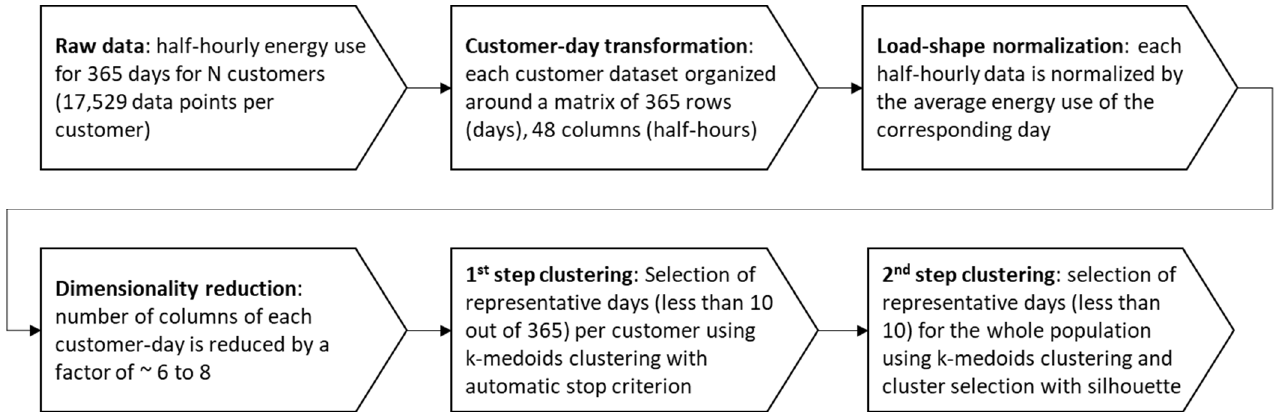
Figure 2. Flow-chart of the data transformation and multi-step time series clustering process.